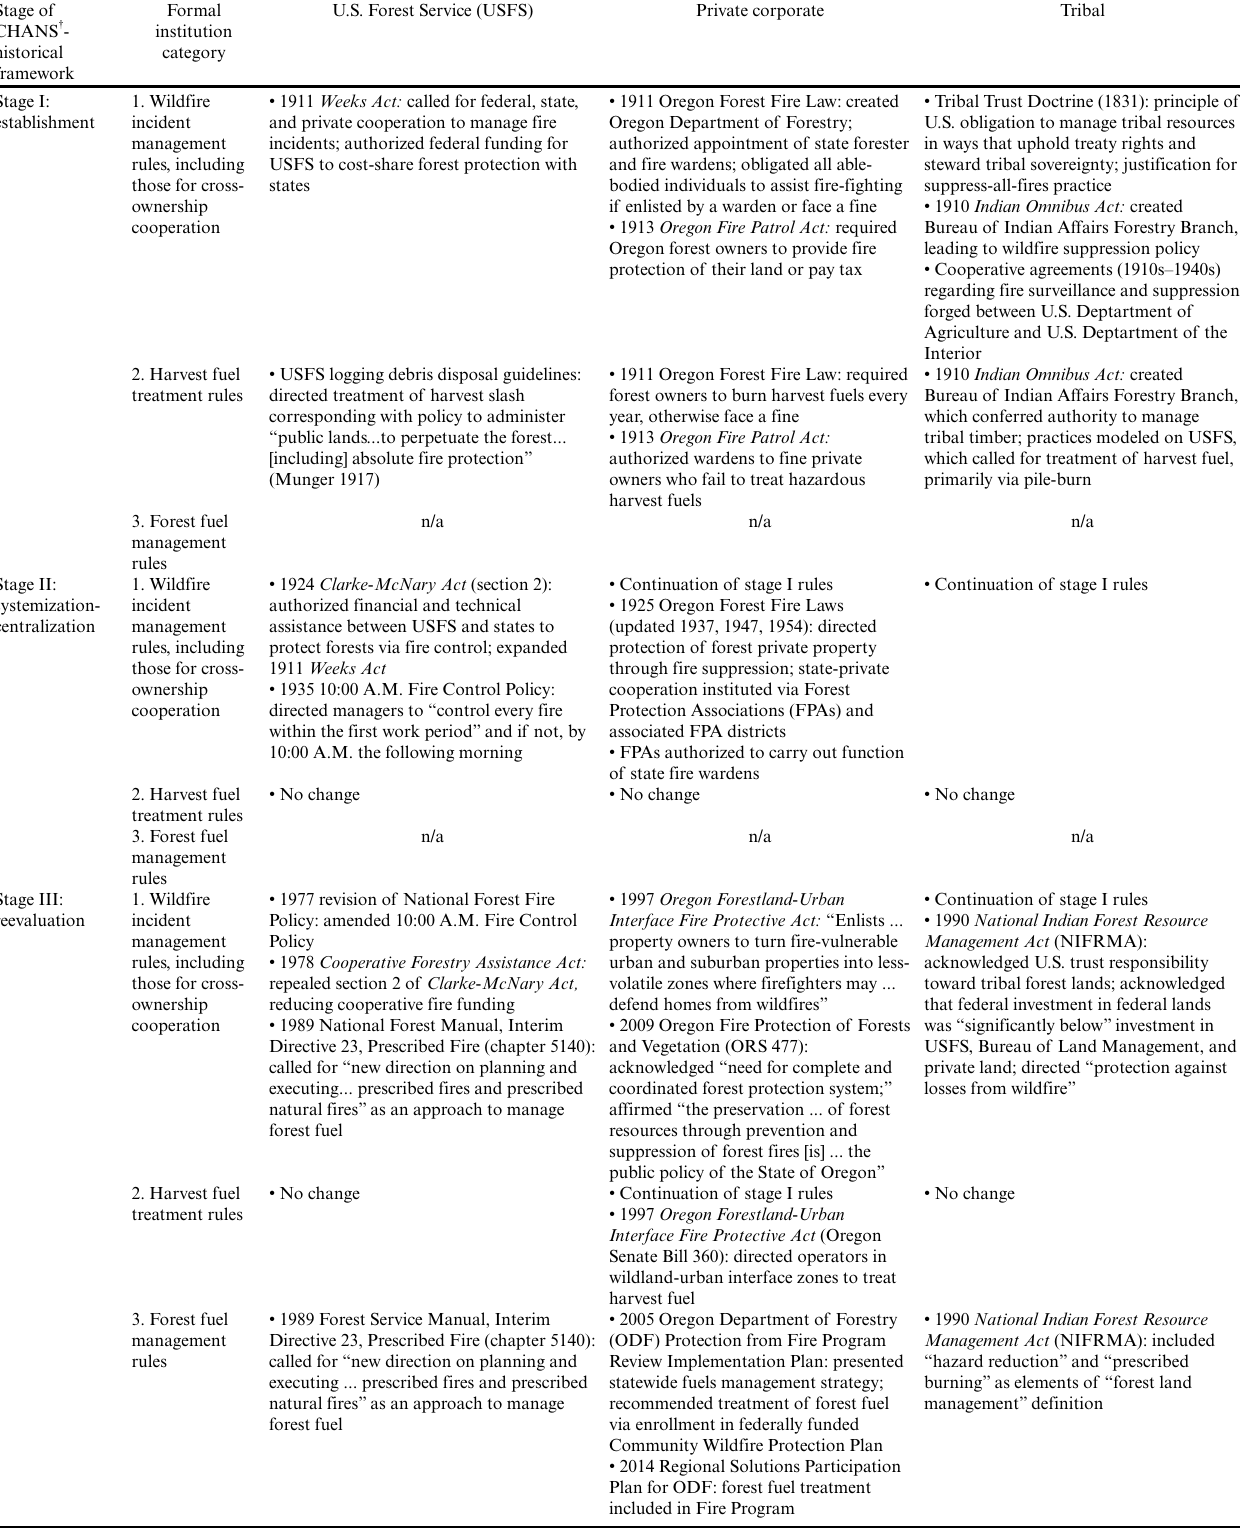
Table 5. Evolution of wildfire formal institutions among U.S. Forest Service, private corporate, and tribal landowner groups. Stage of CHANS †